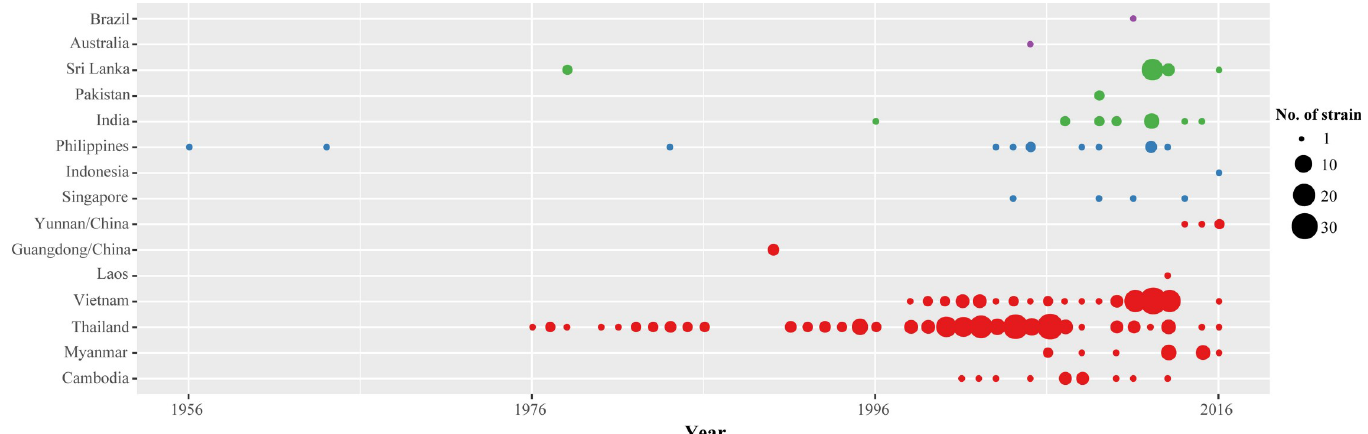
Fig 2. The temporal distribution of DENV 4-I by location. The red color dots represents the strains detected in mainland Southeast Asia and its adjacent provinces of China; similarly, blue depicts those found in maritime Southeast Asia; green those from the Indian subcontinent; and purple those few strains found in circulation elsewhere (Brazil and Australia). The diameter size of the circles corresponds to the number unique strains of DENV 4-I in a given year in a given location.